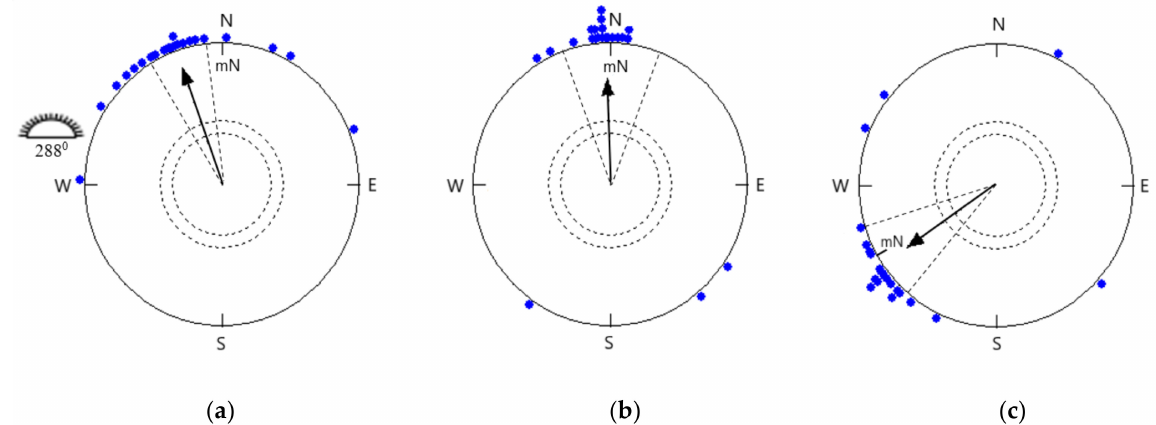
Figure 1. Directional preference of Red-headed Buntings at the experimental site under ( a ) clear sky ( α = 341 ◦ , n = 22, r = 0.872, p < 0.0001; 95% CI = 329 ◦ –353 ◦ ), ( b ) simulated overcast sky ( α = 358 ◦ , n = 22, r = 0.752, p < 0.0001; 95% CI = 340 ◦ –16 ◦ ), and ( c ) 120 ◦ counter-clockwise rotated magnetic field under simulated overcast skies ( α = 236 ◦ , n = 22, r = 0.79, p < 0.0001; 95% CI = 220 ◦ –252 ◦ ) during spring migration. The solid arrow represents the direction ( α ) and length (r) of the grand mean vector. Each symbol (filled dot) on the circumference of the circle depicts the mean heading of an individual bird tested 4 times. The inner and outer dashed circles represent the minimal length of mean vector r at 95% ( p < 0.05) and 99% ( p < 0.01) significance according to the Rayleigh test; radial dashed lines represent the confidence interval (CI), mN denotes the direction of the magnetic north, and the sun symbolizes the mean azimuth angle calculated in the halfway of the experimental hour.